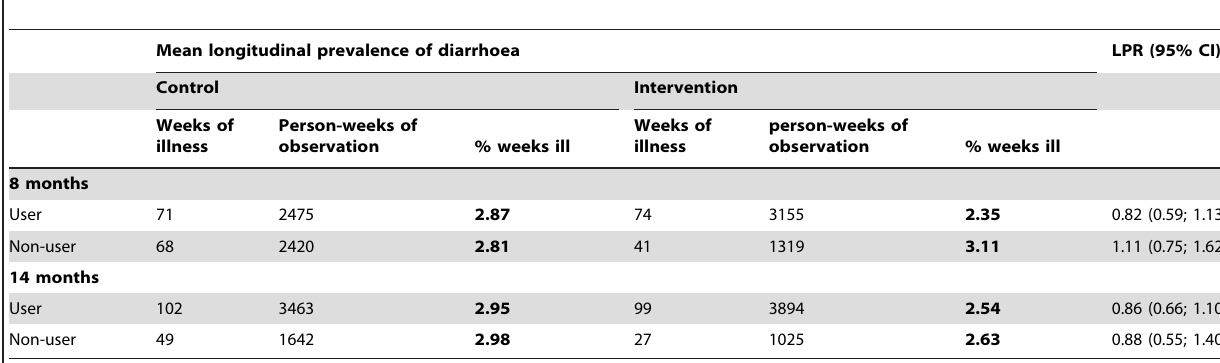
Table 4. Longitudinal prevalence of diarrhoea stratified by reported last time of